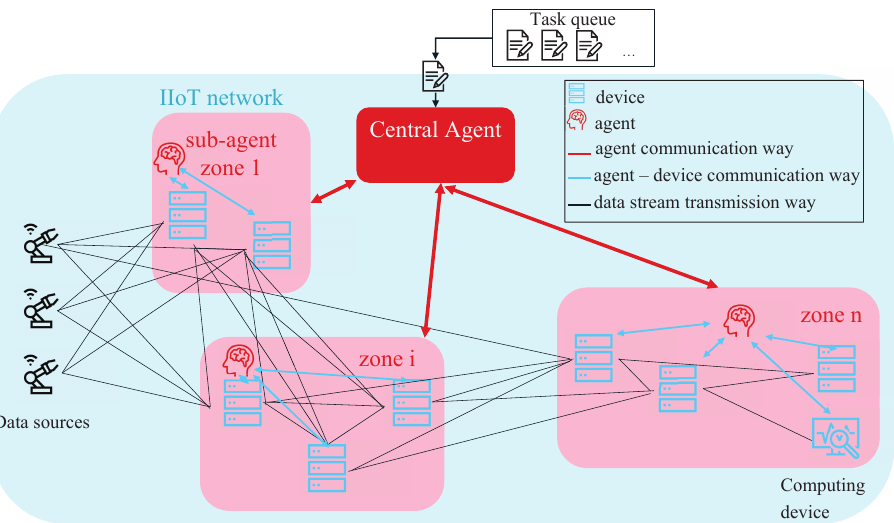
Figure 9. Schematic view on the architecture of the centralized multi-agent approach. The controller receives the incoming tasks to allocate resources for. It communicates with the sub-agents but not with the computing units directly. Depending on the states provided by the sub-agents, the central agent forwards the task to one of the sub-agents, which will further assign the task to one of its observed computing